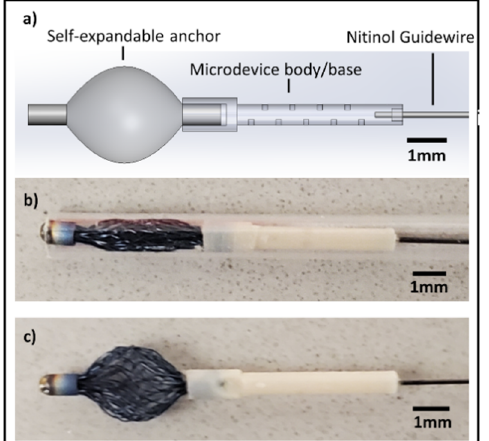
Figure 1. Drug screening microdevice with nitinol anchor attachment. ( a ) Schematic demonstrates the microdevice, which consists of a body with tiny drug reservoirs for precision drug release, a guidewire that enables subsequent localization and retrieval of the microdevice, and a self-expandable anchor that keeps the device secure in tissues. ( b ) Nitinol anchor is shown in collapsed form, which can be loaded into a 17-gauge needle. ( c ) After deployment, the anchor spontaneously expands, increasing the tissue contact surface area for enhanced mechanical stability.